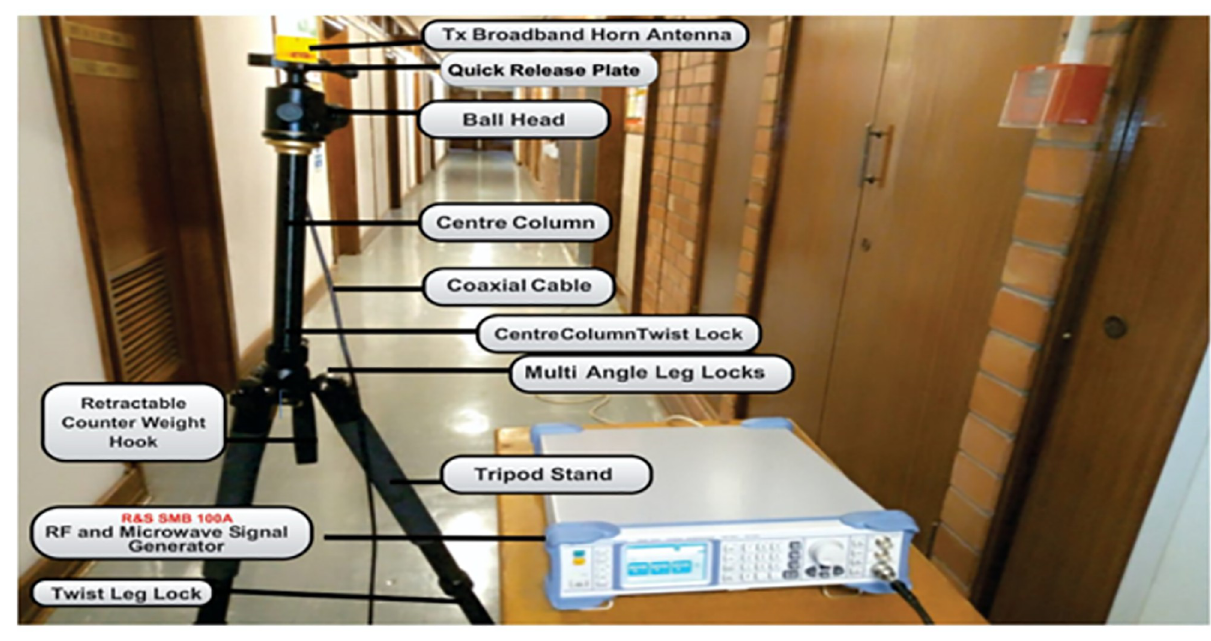
Fig 4. The Tx setup.